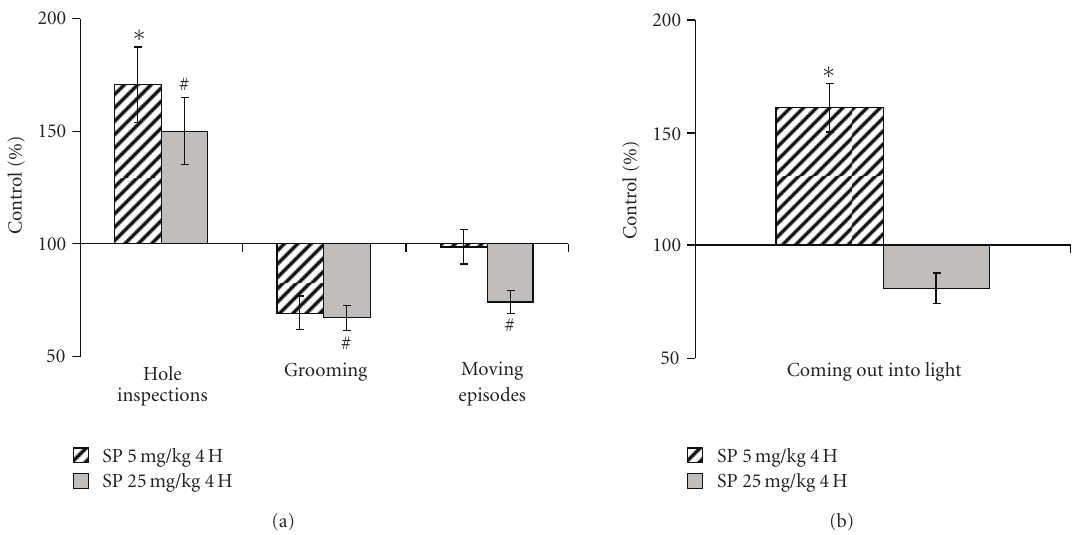
Figure 1: Changed behavioral parameters of male rats tested in the open field (a) and elevated plus maze (b) 4 hours after the treatment with 5 and 25mg/kg SP. Statistical significance: ∗ P < . 05; # P ≤ . 1 .